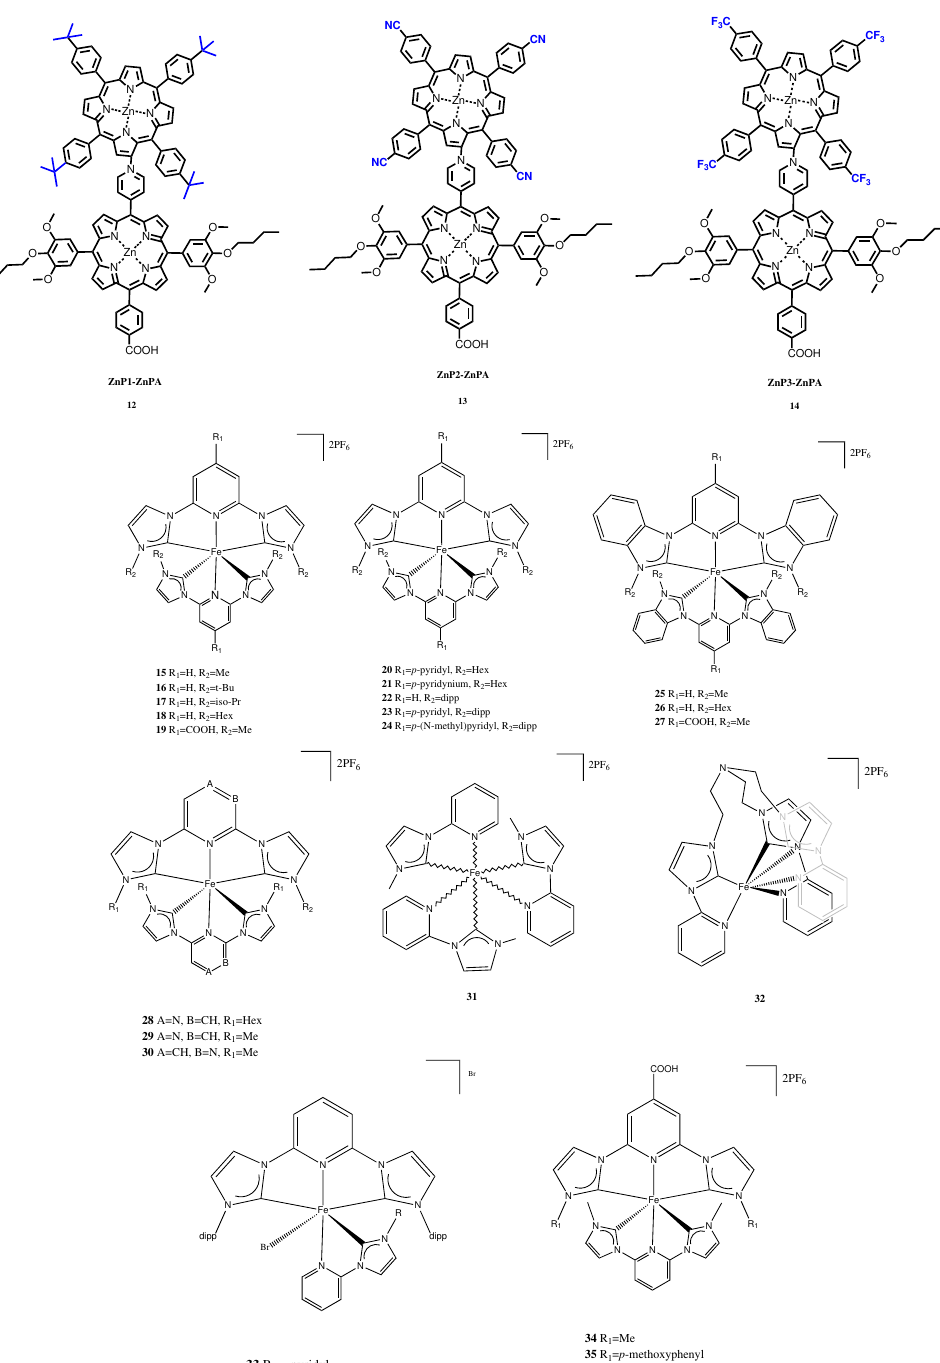
Figure 4. Examples of porphyrin zinc sensitizers ( 12 – 14 ) and photofunctional iron coordination compounds ( 15 – 36 ). Reprinted from [27] with permission of Elsevier and from [28] under a Creative Common CC BY